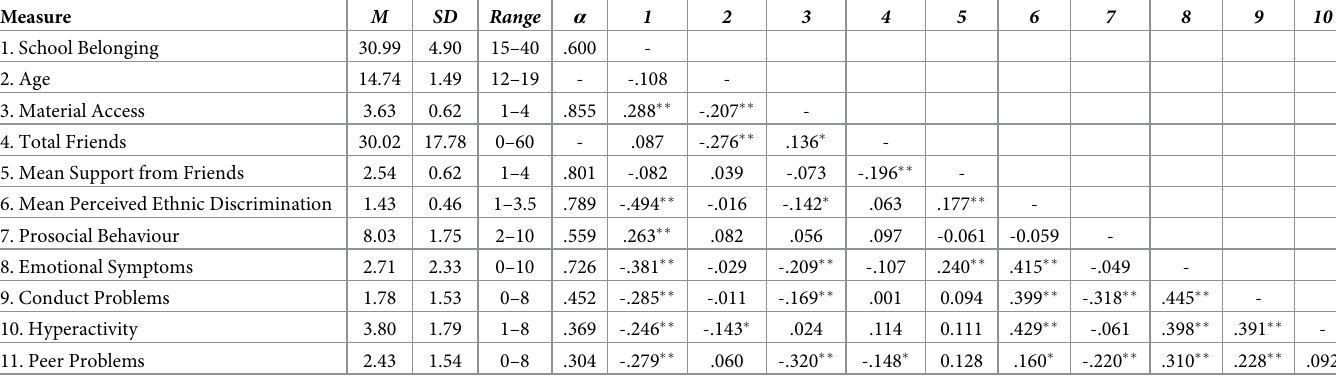
Table 1. Summary of psychometric properties and intercorrelations for continuous variables.